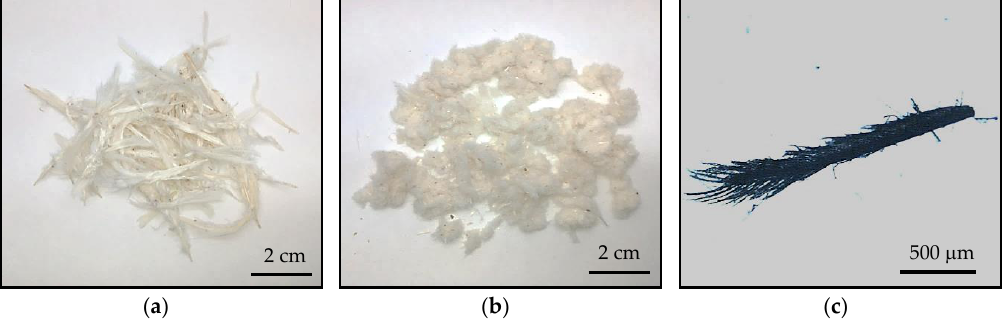
Figure 2. ( a ) Sanitized chicken feathers (CFs), ( b ) ground sanitized CFs and ( c ) 50× magnification of ( b ).